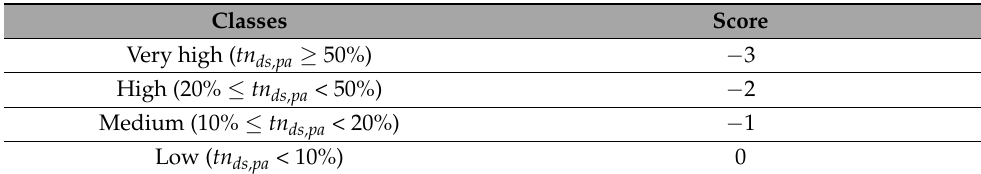
Table 16. TN ds,pa —temporal noise. Classes